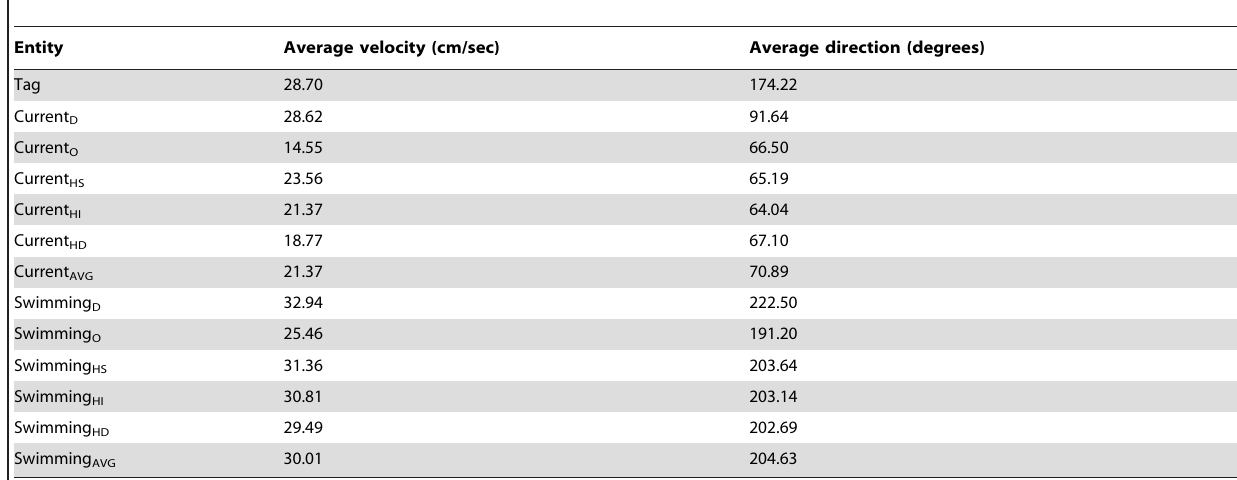
Table 2. Summary of velocity and direction for movements by Tag, Current D , Current O , Current HS , Current HI , Current HD , Swimming D , Swimming O , Swimming HS , Swimming HI , Swimming HD , and Swimming AVG